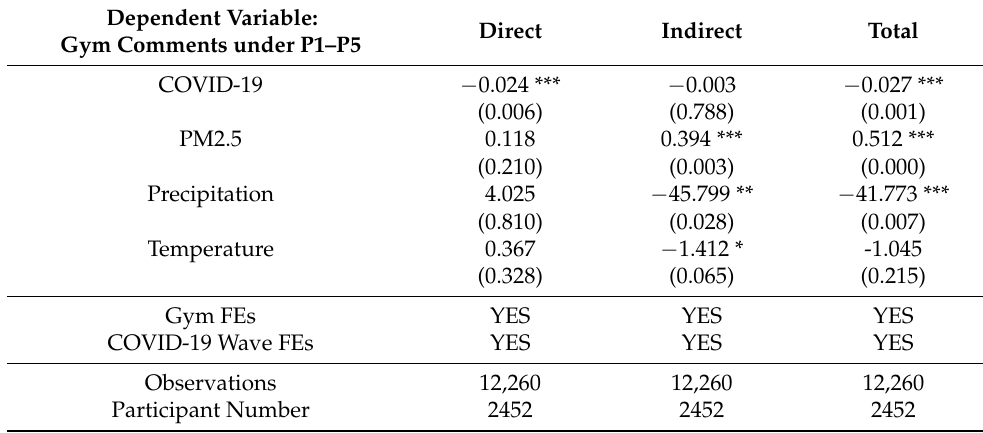
Table 8. Direct effect, indirect effect and total effect of the SDM